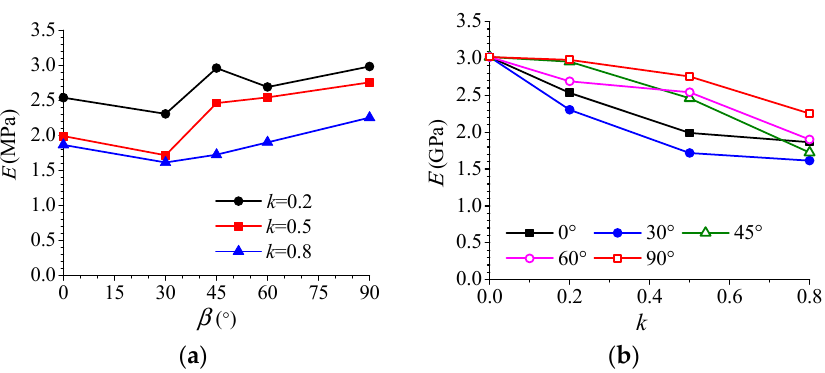
Figure 4. The peak strength vs. two geometrical parameters of the laboratory tests. ( a ) σ p vs. β ; ( b ) σ p vs. k.